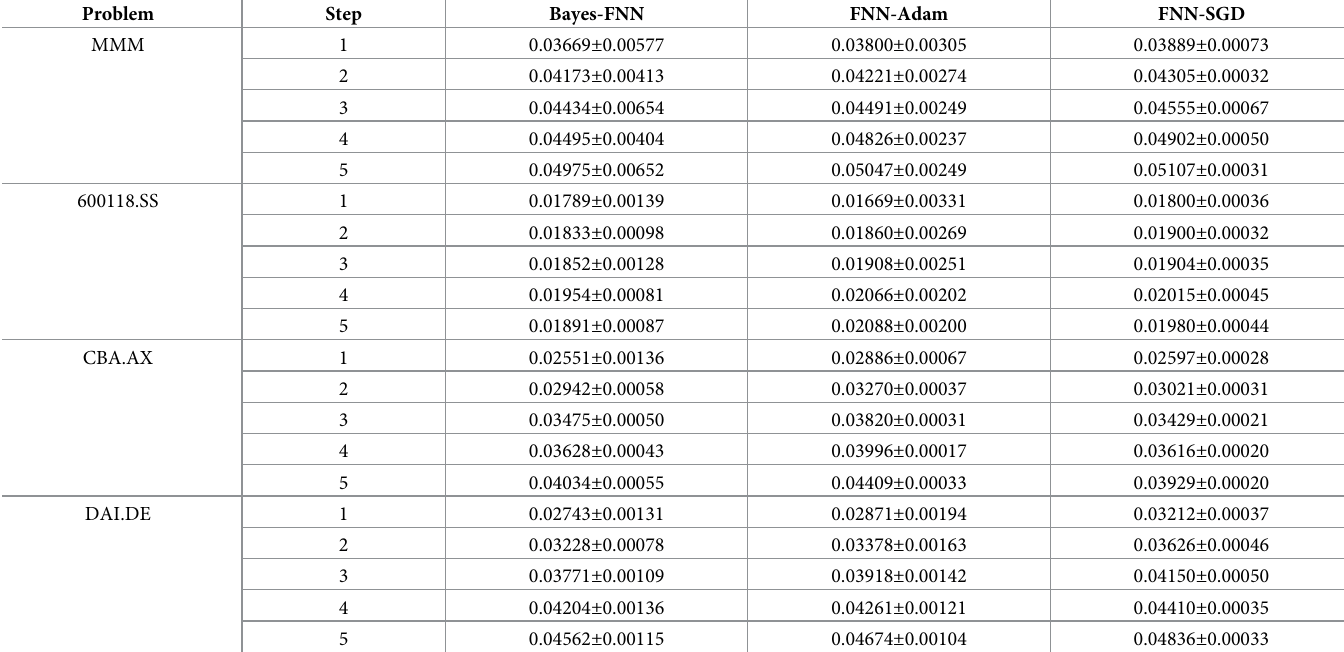
Table 2. Multi-step-ahead prediction